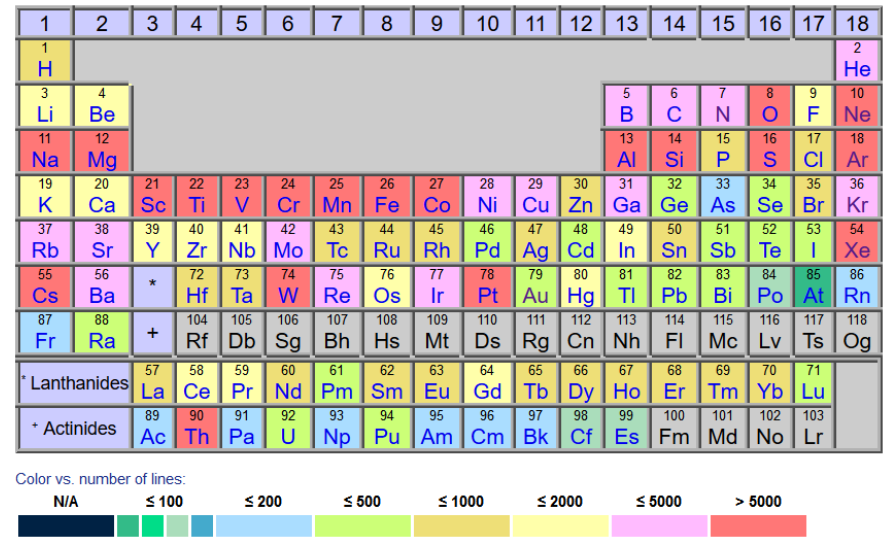
Figure 1. Contents of ASD version 5.7.1 (released in October 2019) for spectral